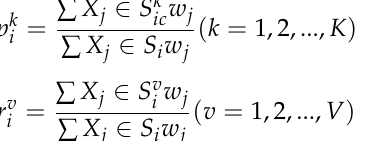
Figure 6. Theoretical line loss calculation of low-voltage grids based on random forest.